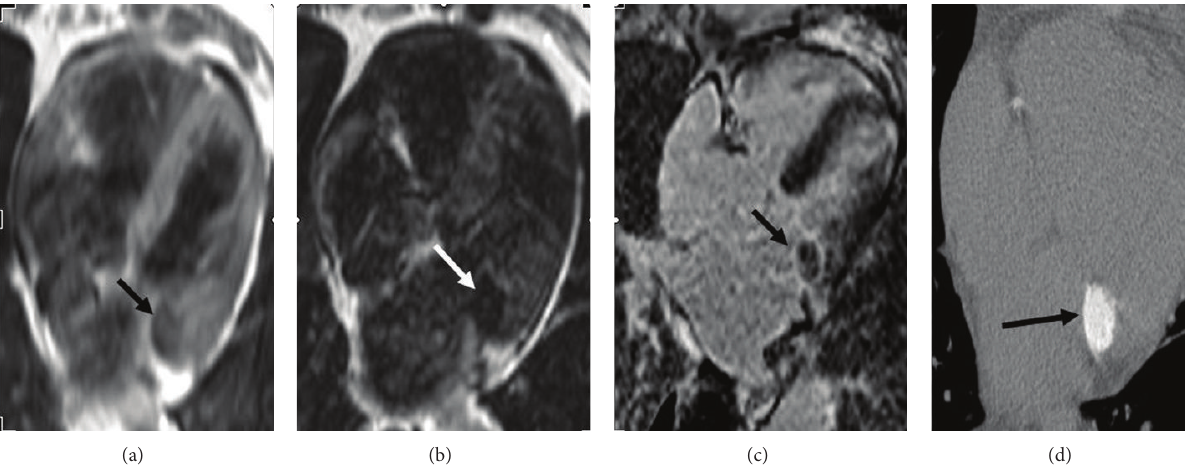
Figure 1: T1-weighted (a) and T2-weighted (b) turbo spin echo images show hypointense round mass-like lesion (black and white arrows). Delayed postcontrast cardiac MRI image (c) shows peripheral enhancement (black arrow). Multislice noncontrast computed tomography image (d) shows round calcification (black arrow) located in mitral annulus.